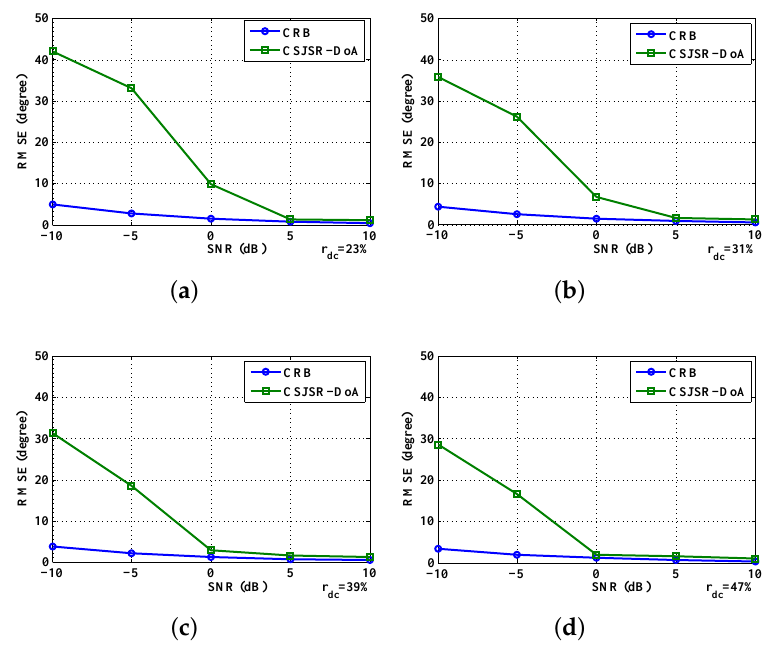
Figure 5. Comparison between the CSJSR-DoA result and the Cram´ e r–Rao bound (CRB): ( a ) CRB comparison with r dc = 23%; ( b ) CRB comparison with r dc = 31%; ( c ) CRB comparison with r dc = 39%; ( d ) CRB comparison with r dc = 47%.